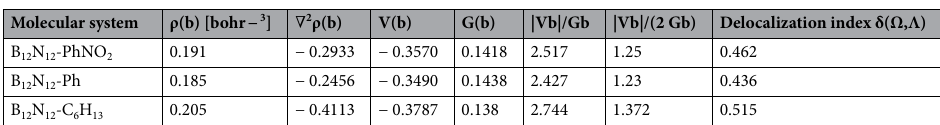
Table 3. Obtained valiues of QTAIM parameters of the bare and grafted B 12 N 12 nanocage cluster.